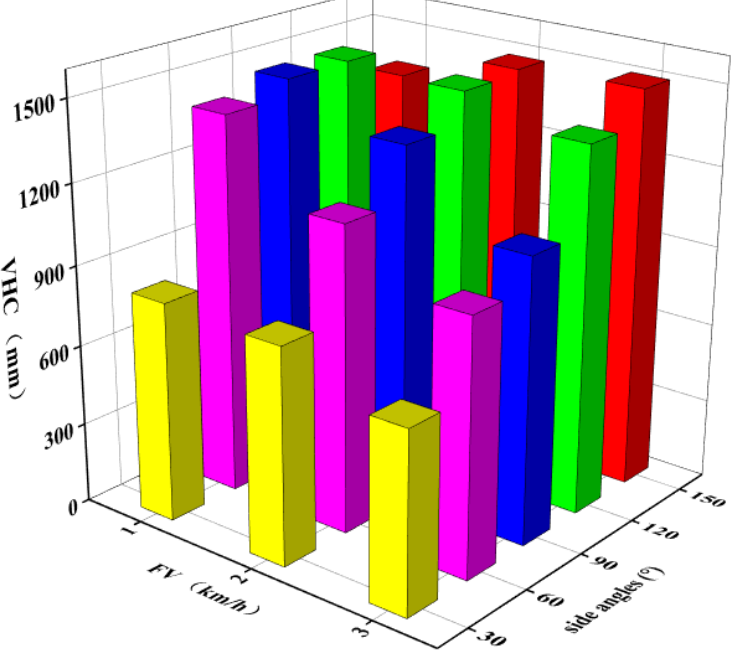
Figure 12. Average value of maximum